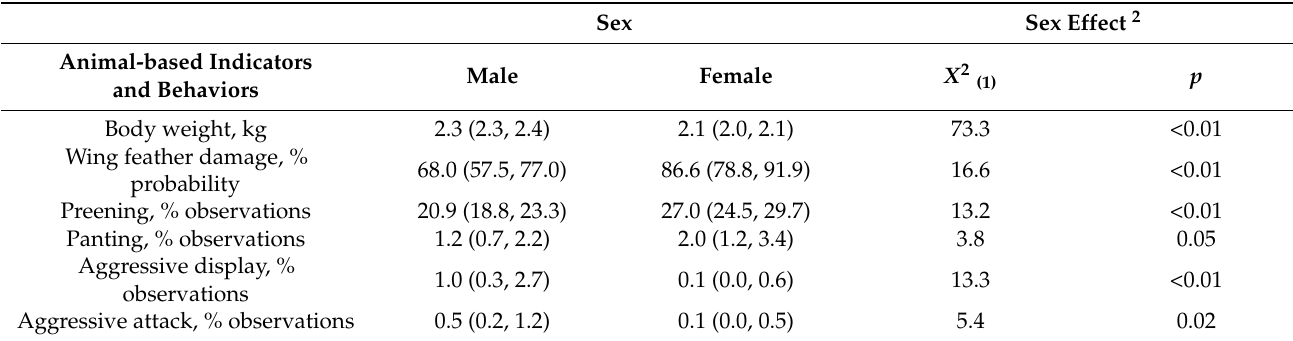
Table 3. Means ± 95% CI of animal-based indicators and behaviors affected by sex for mixed-sex Freedom Ranger chickens raised in a free-range system from 5 to 11 weeks of age 1 .